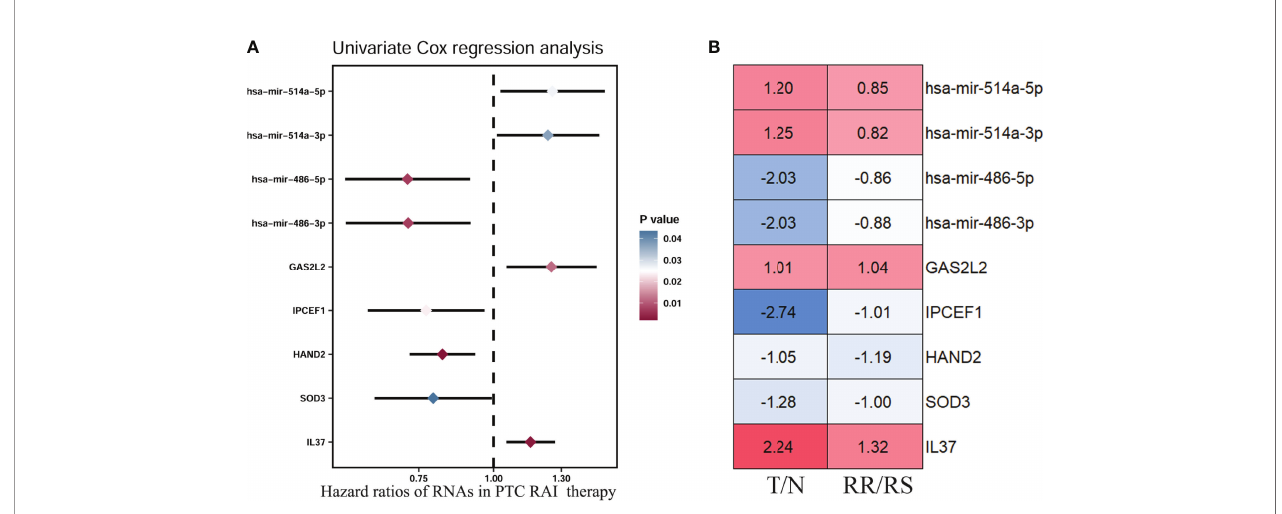
FIGURE 4 | Prognostic value of single-candidate RNA. (A) The forest map results of the univariate Cox regression analysis of the nine screened variables in PTC patients who received RAI therapy. (B) Module diagram showing the log2 fold change (FC) of the nine RNAs between tumor vs. normal (T/N) groups and RAI- refractory vs. RAI-sensitive (RR/RS) groups.